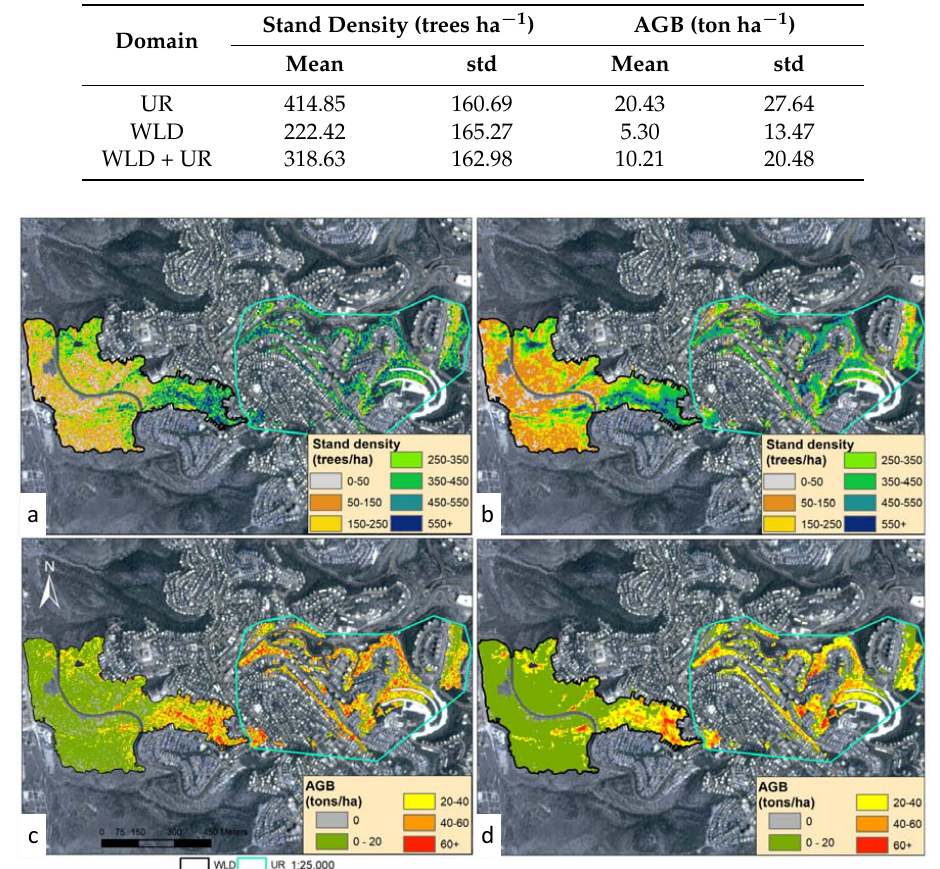
Figure 5. Stand density retrieved from GCC using ( a ) Planet (3 m) and ( b ) Sentinel-2A (10 m) images; and woody aboveground biomass retrieved from Equation (1) and DBH derived using GCC from ( c ) Planet and ( d ) Sentinel-2A.